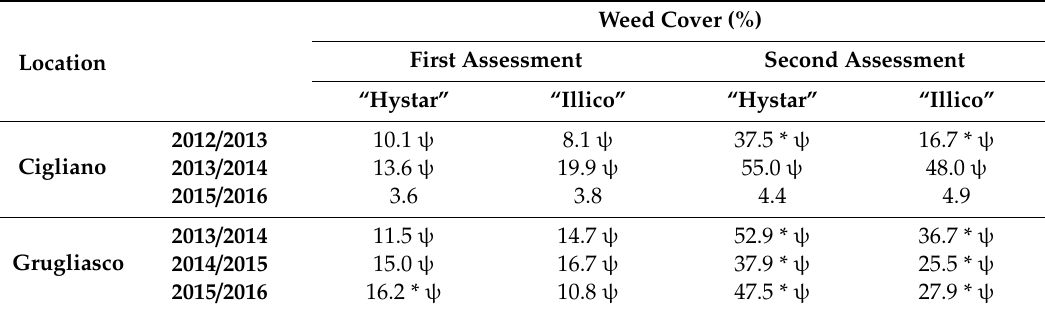
Table 5. Weed cover (percent of ground cover) measured at the two locations in the period 2012–2016 on WEEDED